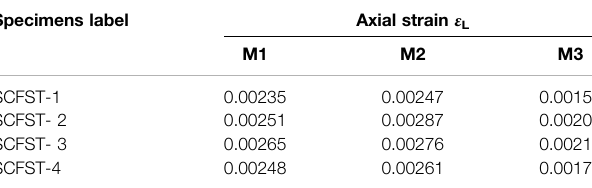
TABLE 2 | Details of specimens and their load-bearing